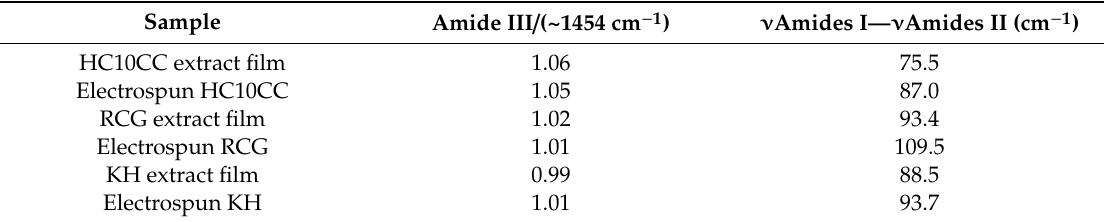
Table 5. Ratio between Amide III to the absorption band of –CH 2 – (~1454 cm − 1 ) and ν Amides I - ν Amides II evaluated from ATR-FTIR spectra for extracted proteins compared with electrospun samples.